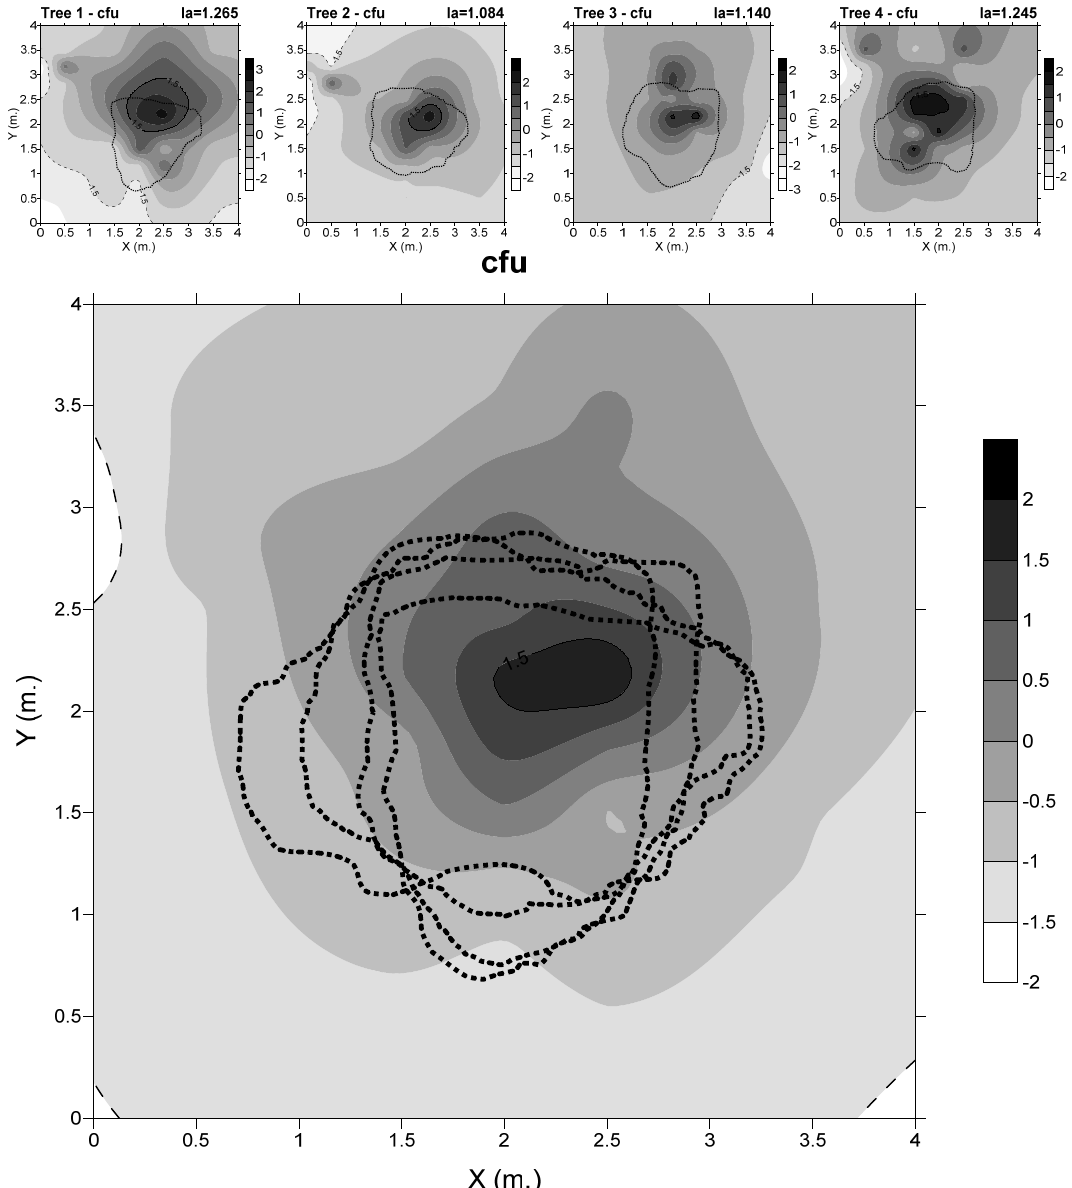
Figure 3. Maps of clustering indices ( ν ) of the cfu for the four sampled trees (top) and the mean for all the trees (bottom). The dark areas show cfu clustering patches ( ν > 1.5) delimited by a continuous line, and the light areas show clustering gaps ( ν < − 1.5) delimited by a discontinuous line. The dotted lines represent the crown cover of each tree. ( I a ): General aggregation index. Legend ( ν ) is unitless.